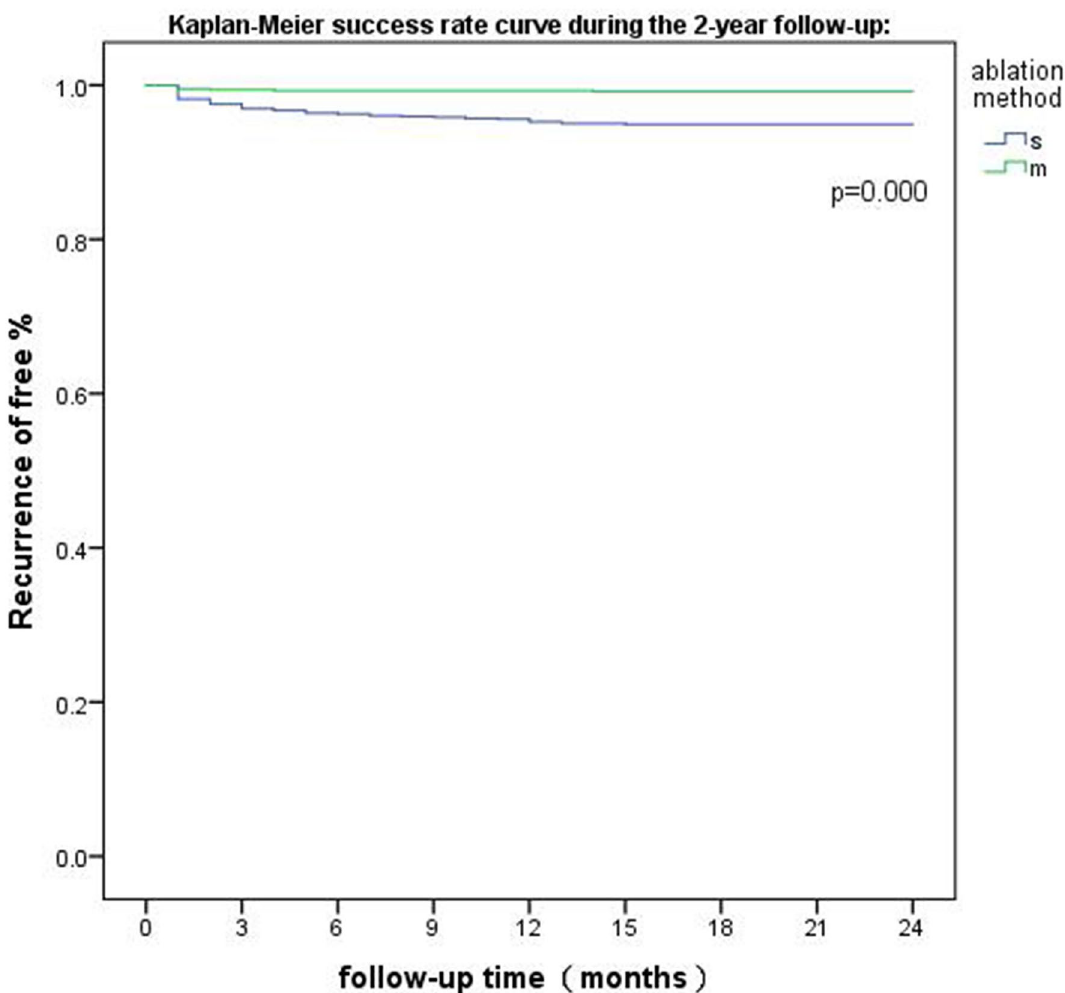
Figure 3. The survival curves of the two groups during the 2-year observation period. The cumulative recurrence rate at every observation time point was significantly lower in group M than in group S. Group M showed an advantage in terms of a high ablation success rate (log-rank test (Mantel-Cox) p value < 0.05).